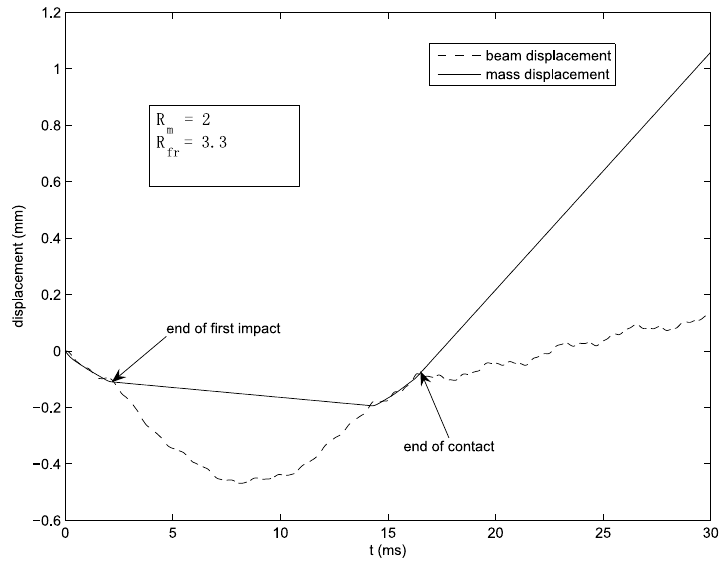
Fig. 3. Mass-beam impact: beam mid-span displacement and mass